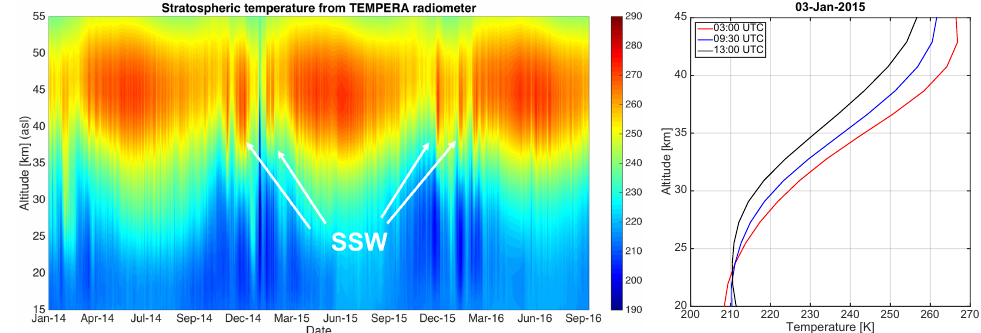
Figure 5. Left: stratospheric temperature evolution from TEMPERA radiometer. Some SSW events are indicated by white arrows. Right: an example of strong variation of temperature in the stratosphere for a winter day.